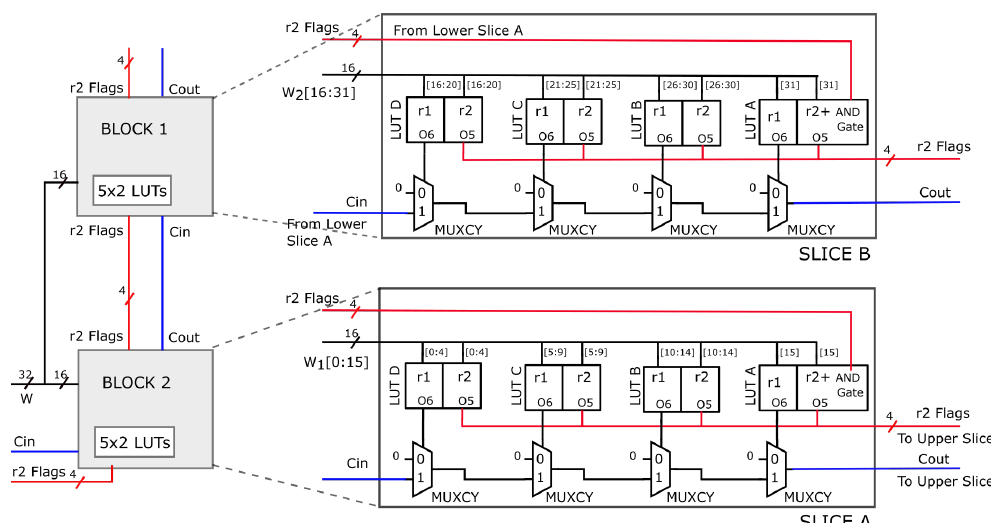
Figure 4. Architecture of Proposed method for a 2 × 32 TCAM.